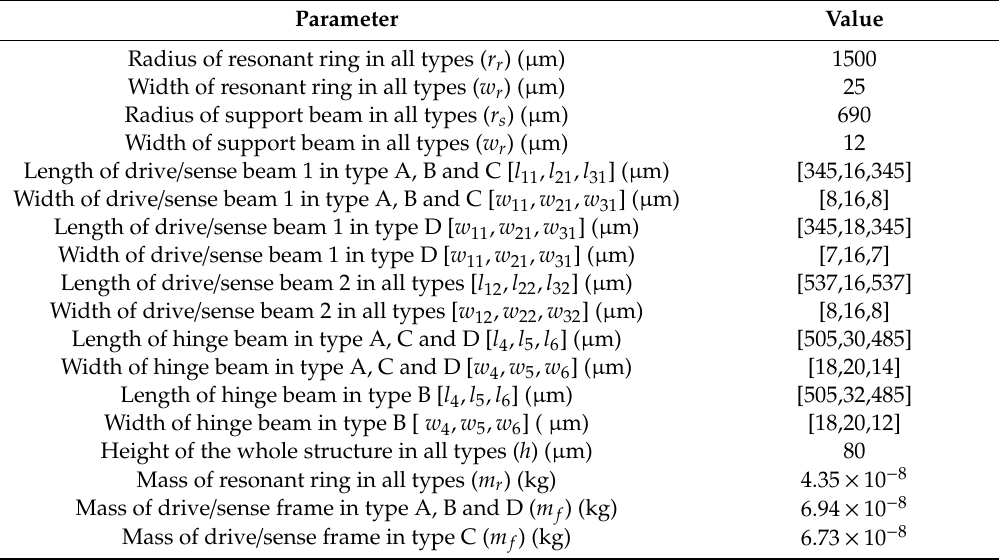
Table 1. Main parameters of the structures.